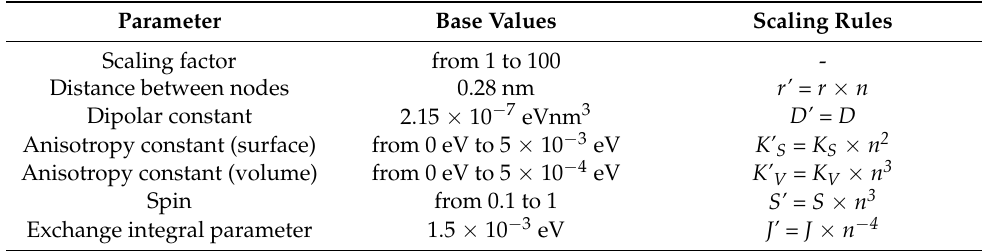
Table 1. Values of the simulation parameters and scaling roles used in this work.